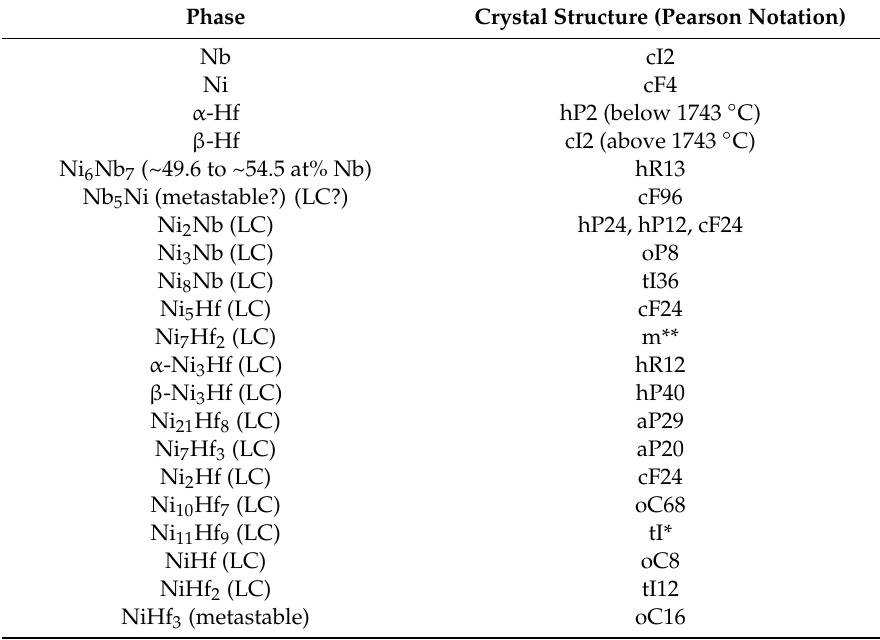
Table 2. Crystallographic data of phases based on Nb, Ni and Hf (synthesized from the di ff erent references mentioned in the present paper). In Pearson notation [56], the first letter refers to the crystal family, the second letter to centring type, the number corresponds to the number of atoms in the unit cell. The asterisk * stands for unknown crystallographic characteristic. LC stands for Line Compound (or fixed